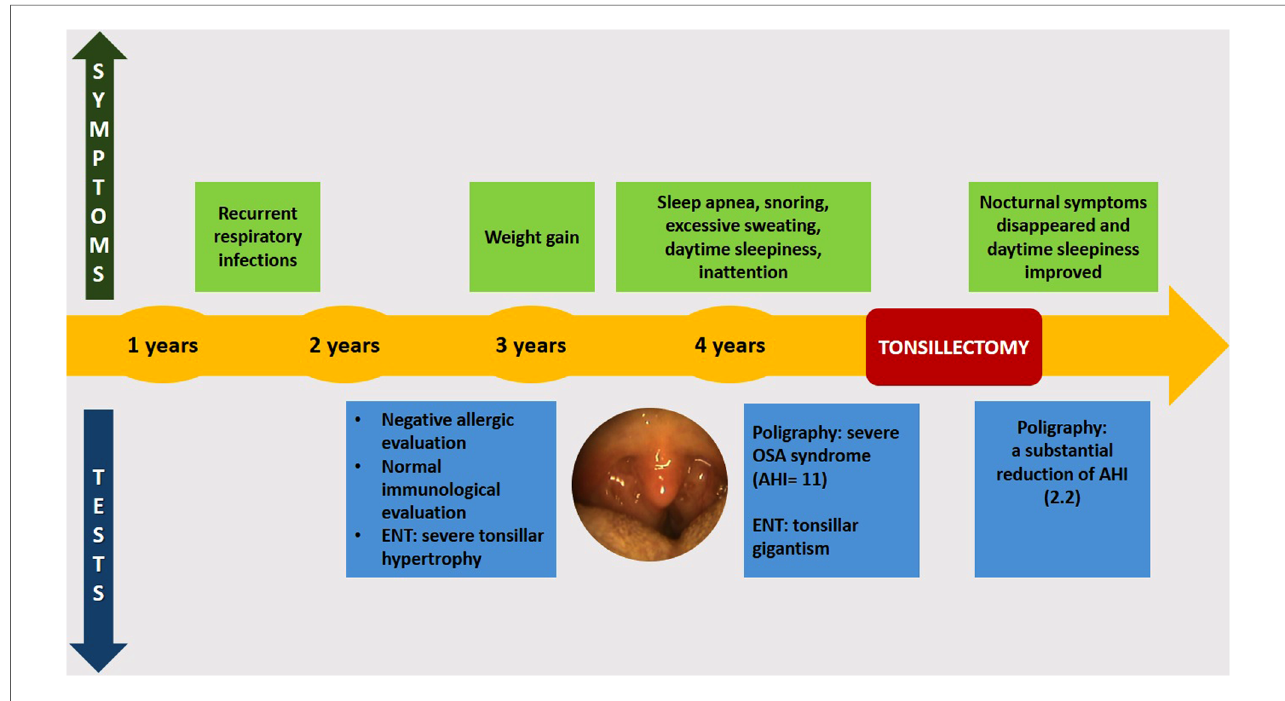
FIGURE 2 Timeline of the clinical course before and after surgery. ENT, ear, nose, and throat; OSA, obstructive sleep apnea; AHI, apnea – hypopnea